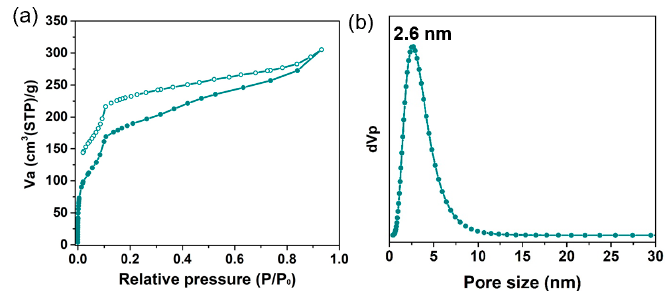
Figure 3. ( a ) N 2 absorption isotherms of Zn-Por-TT COF at 77 K; ( b ) pore size distribution profile of Zn-Por-TT COF.